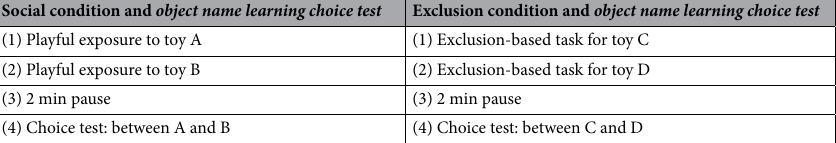
Table 1. Testing procedure. The table illustrates the testing procedure used for testing Whisky and Vicky